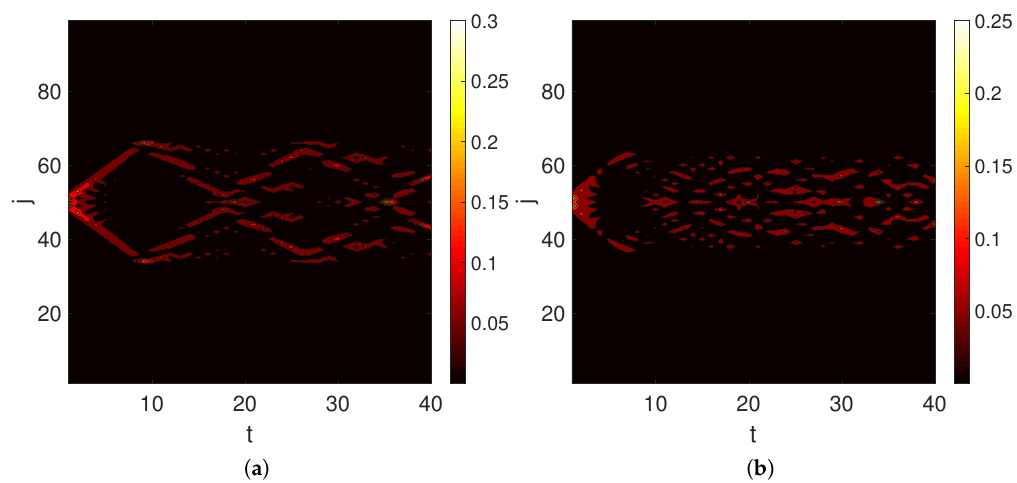
Figure 6. Plot of the transition probability π 50, j for a quantum particle located at t = 0 at position v = 50 of a barbell graph consisting of two cliques of 33 nodes separated by a path of 33 nodes ( a ) without LRI ( b ) and with L s = 2 . The central region consisting of nodes 34–66 is formed by the path. The colobars correspond to the transition